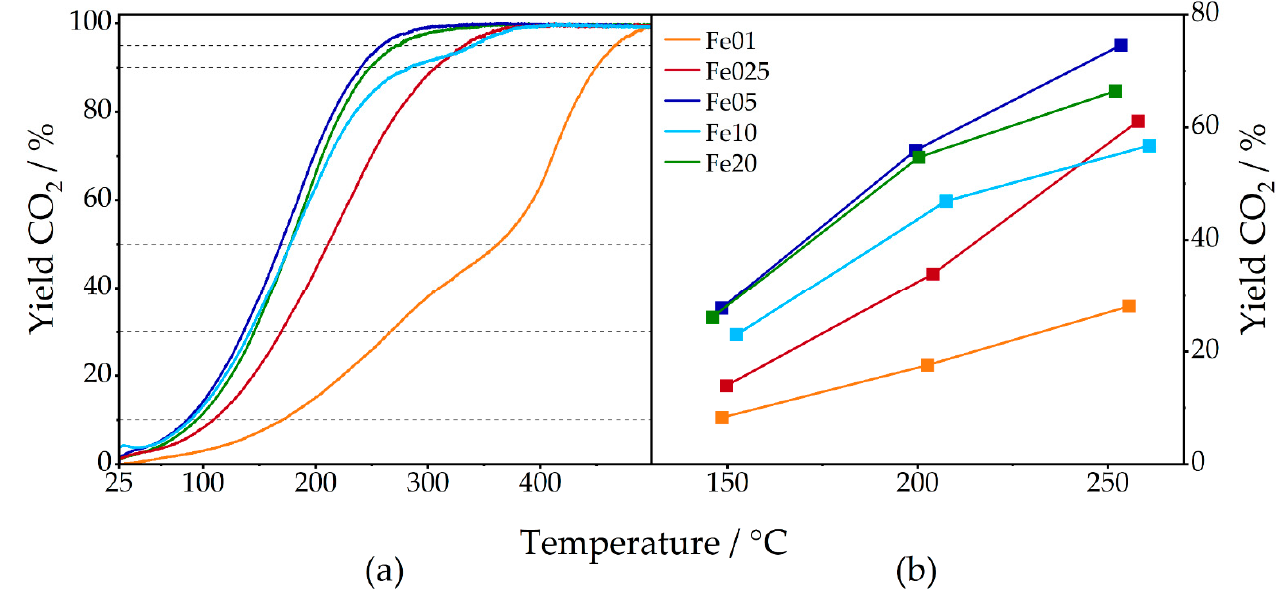
Figure 12. Percentual CO 2 yield of Fe01 to Fe20 in measurements with continuous heating ( a ) and at constant temperatures ( b ); CO 2 yield of 10, 30, 50, 90, and 95% marked with dashed lines; for detailed information, see SI.